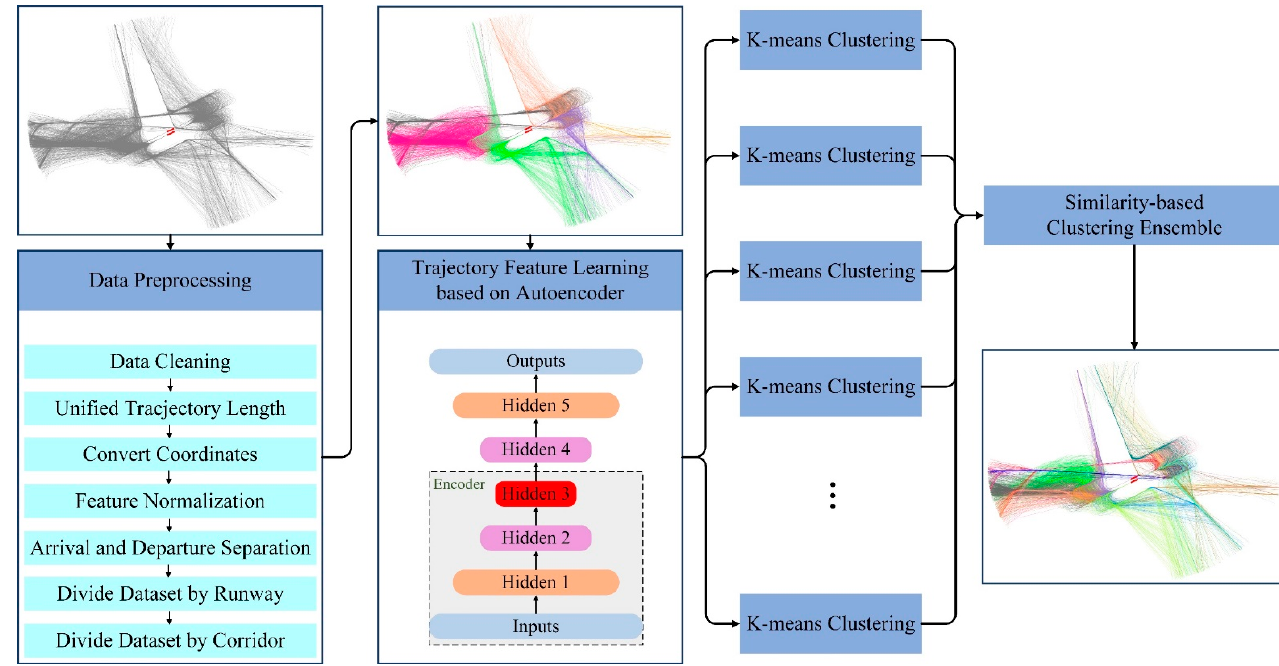
Figure 1. The framework of the proposed method.